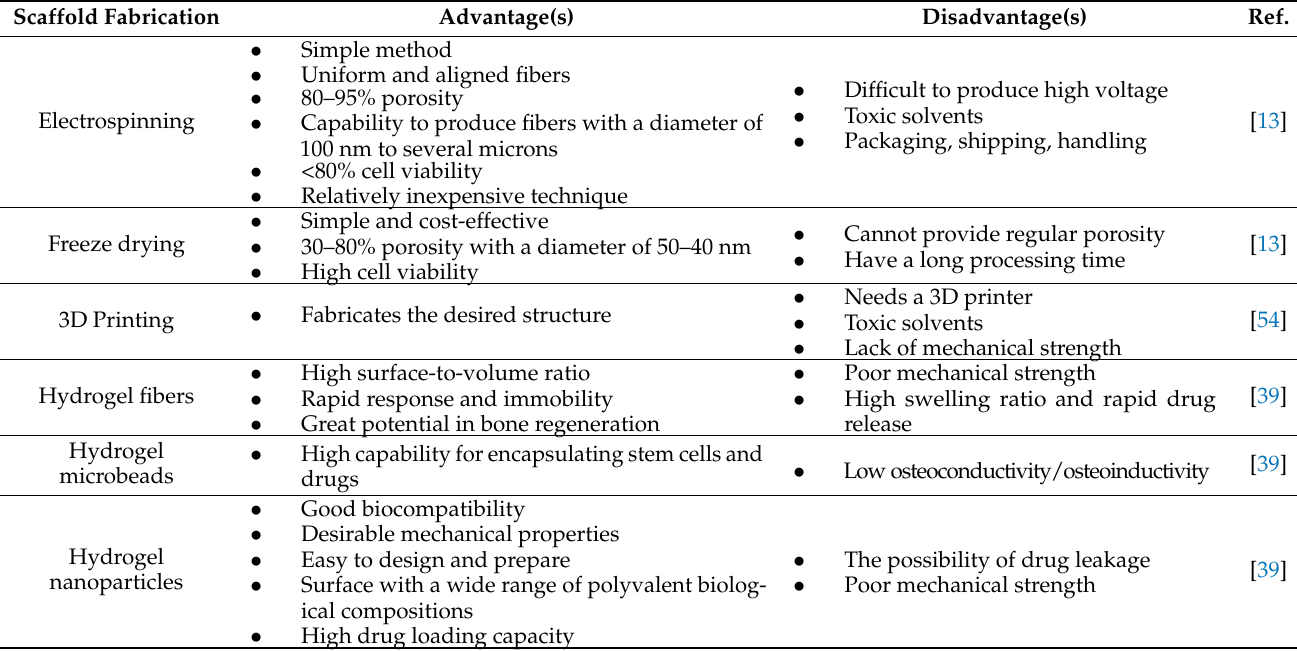
Table 2. Benefits and disadvantages of fabrication